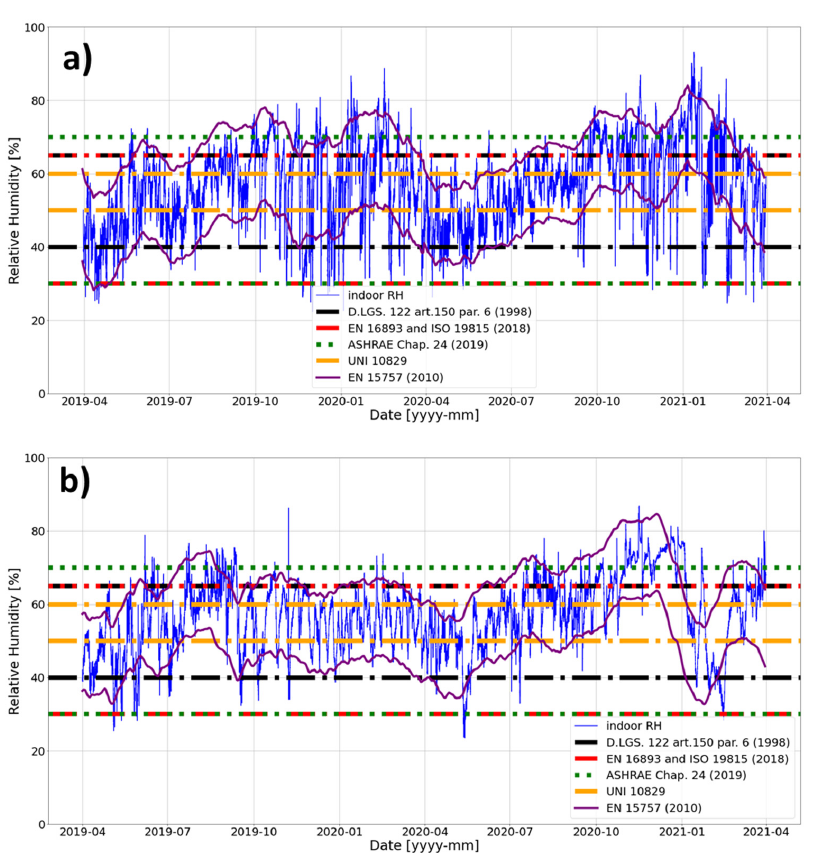
Figure 5. Indoor RH timeseries in Ringebu ( a ) and Heddal ( b ) church, together with the thresholds defined by the standards: D. Lgs. 122 art. 150 par. 6 (black dashed line), UNI 10829 (orange dashed lines), EN 16893 and ISO 19815 (red dashed lines), ASHRAE Chap. 24 (green dotted lines), EN 15757 (purple curves).